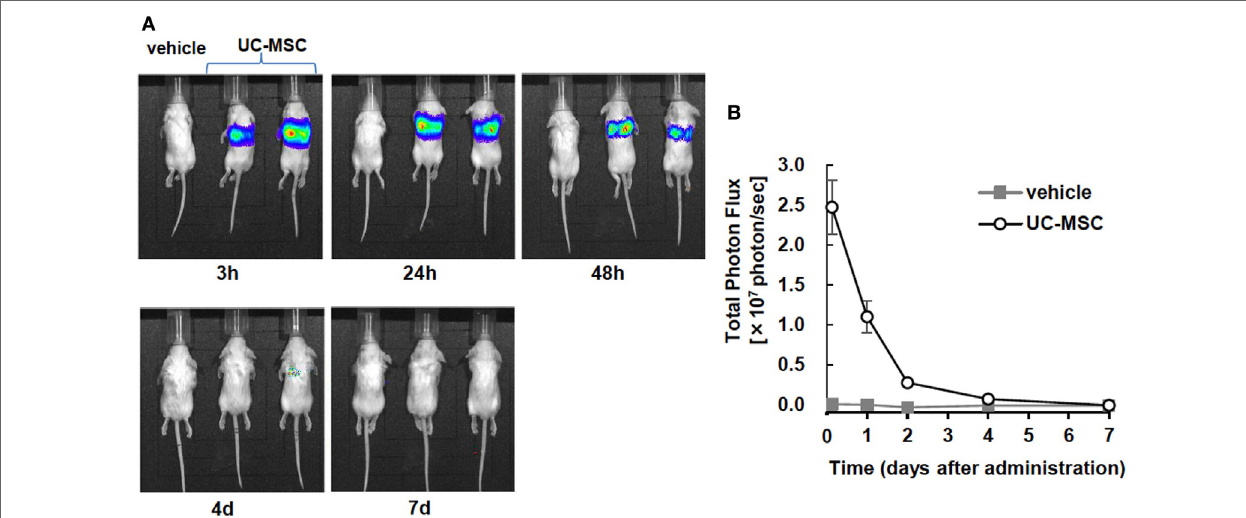
FigUre 7 | In vivo imaging of intravenously injected umbilical cord-derived MSCs (UC-MSCs). (a) Representative images of in vivo imaging taken at 3 h, 24 h, and 48 h and 4 days and 7 days after the intravenous injection of UC-MSCs. (b) Quantification of the total photon flux in the vehicle- and UC-MSC-treated groups. UC-MSCs were trapped in the lungs, and the intensity of photon flux decreased over time. We did not detect the signal in brain tissue (vehicle n = 1 and UC-MSC n =